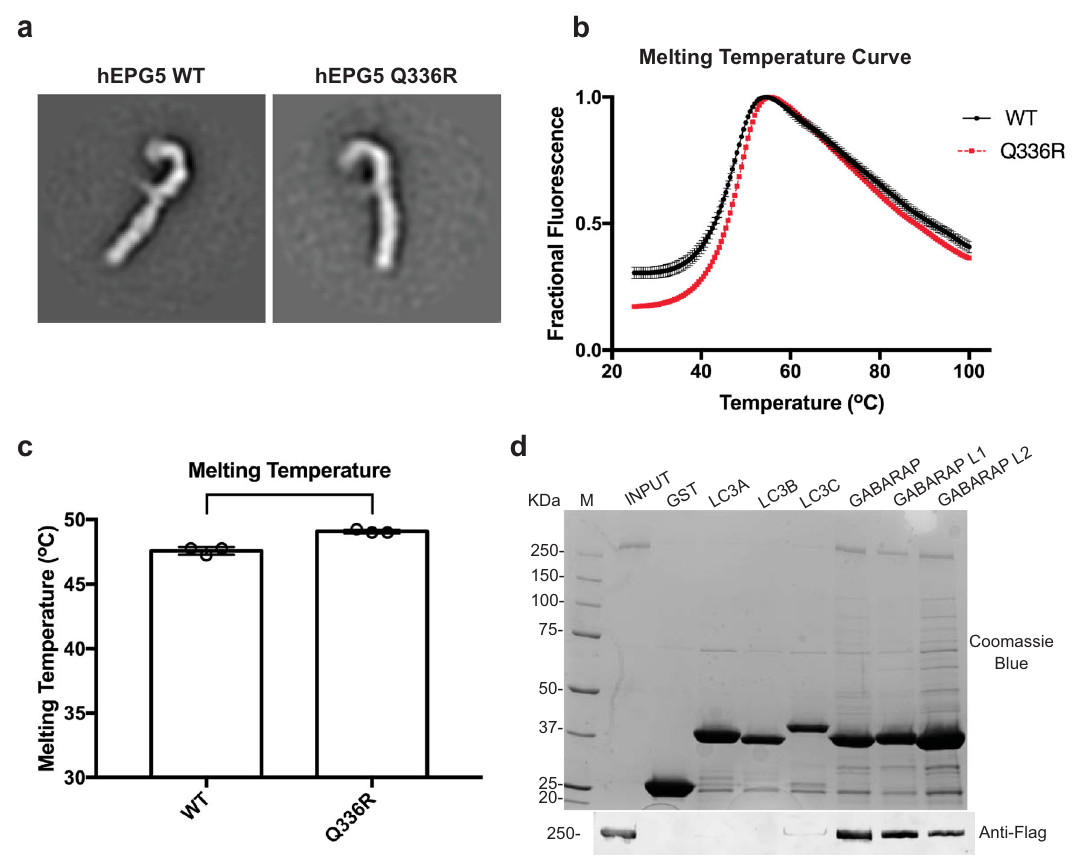
Fig. 6 Vici syndrome mutant hEPG5 Q336R has the same binding speci fi city and overall architecture as hEPG5 WT . a Representative 2D class averages of hEPG5 Q336R (right panel) alongside hEPG5 WT (left panel). b Thermo shift assay of hEPG5 WT and hEPG5 Q336R . hEPG5 WT is shown in black and hEPG5 Q336R is shown in red. Data are shown as mean ± SEM of three individual experiments. c Melting temperatures derived from the fi rst derivative of the melting temperature curve shown in bar graph. Data are shown as mean ± SEM of three individual experiments. d In vitro pull-down assays of hEPG5 Q336R with GST (control) and GST-tagged LC3/GABARAP subfamily proteins used as baits. Representative SDS – PAGE stained with Coomassie Blue (top panel) shows the hEPG5 Q336R and GST constructs input, and representative western blot (bottom panel) was probed by anti-FLAG antibodies. M represents the protein marker. Experiments were performed in